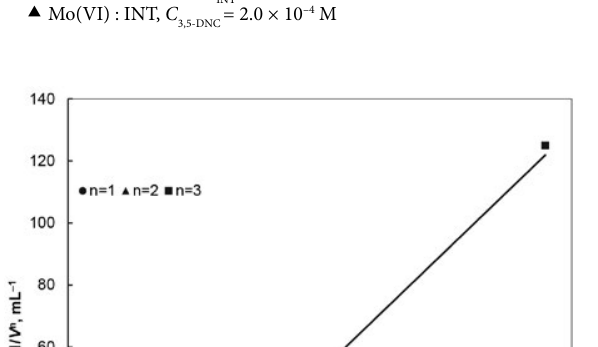
Figure 2. Straight lines by the mobile equilibrium method for deter- mination of the molar ratios Mo(VI):3,5-DTC and Mo(VI):INT = 2.08 × 10 ‒5 M; C = 4.0 × 10 –1 M; C Mo(VI) H2SO4 λ = 395 nm; τ = 1 min